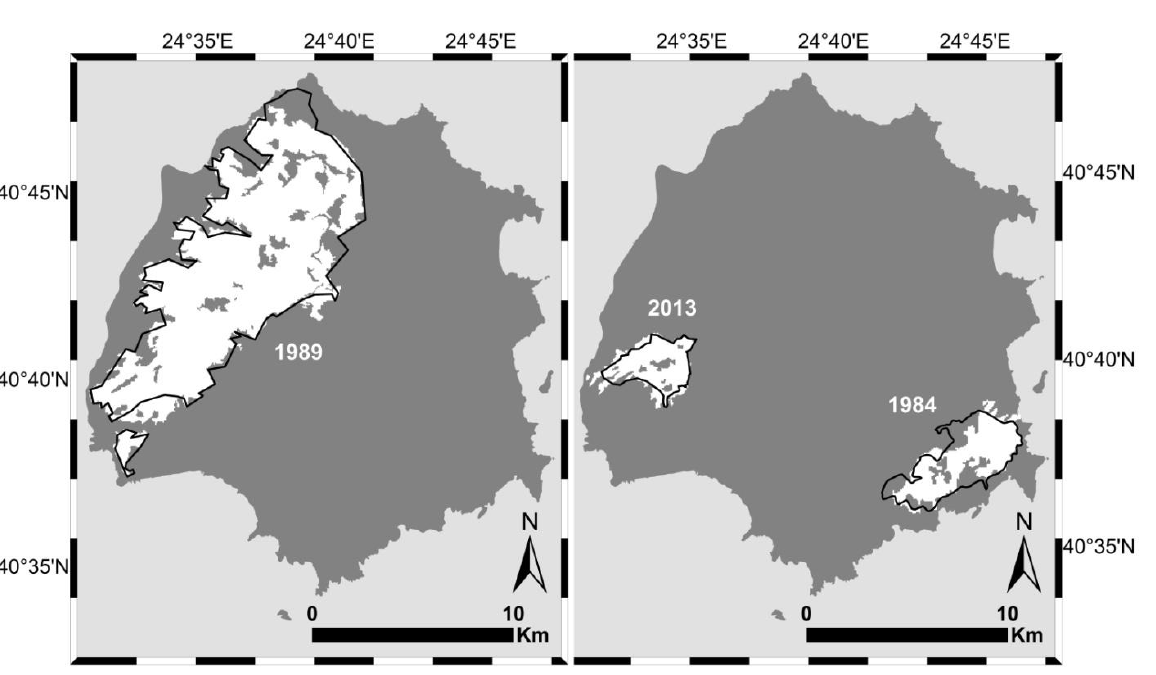
Figure 4. Burned area maps (in white) of the study area derived after applying the OBIA classification model. The forest service perimeters are displayed in